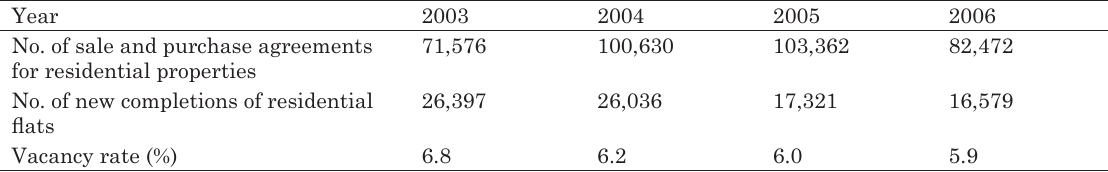
Table 2. Numbers of sale and purchase agreements for residential properties, new completions of residential flats and vacancy